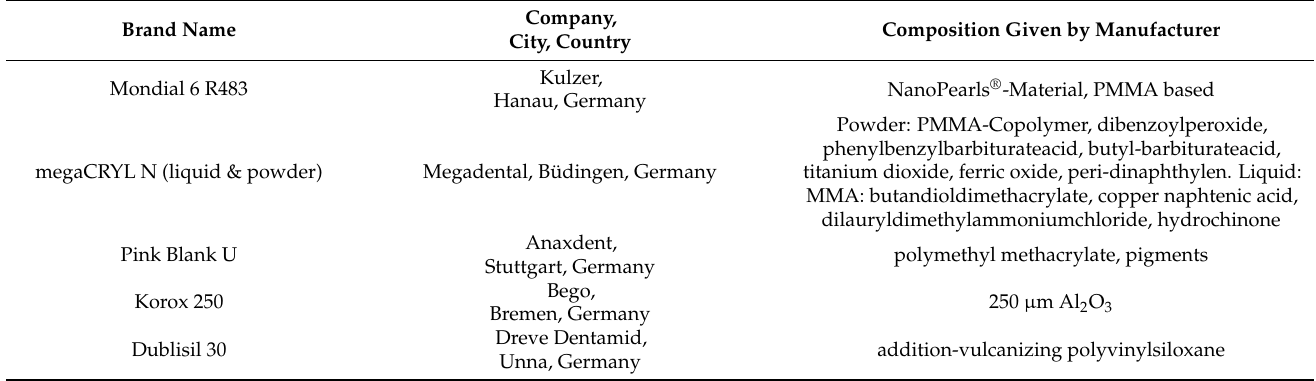
Table A1. Description of Materials used in the